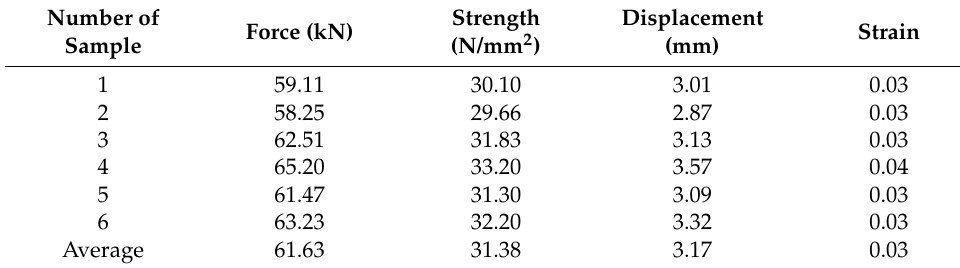
Table 3. Compressive strength for 28 days of